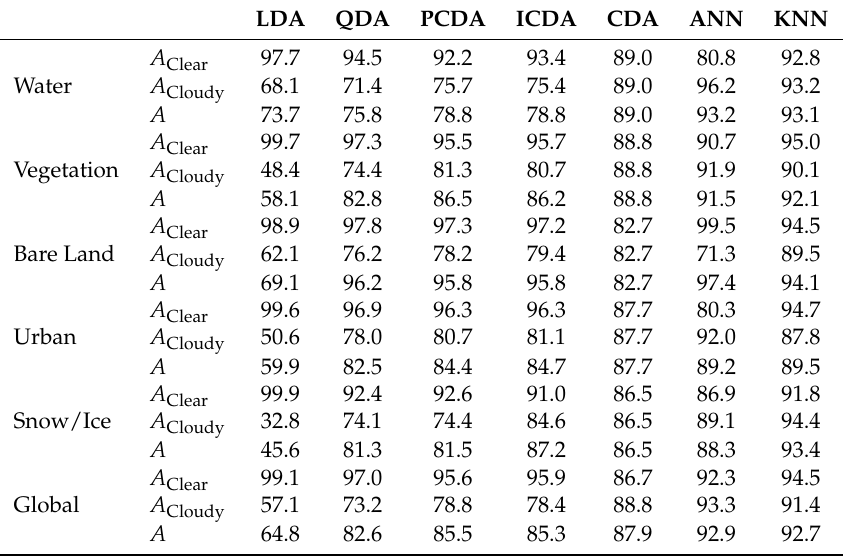
Table 7. Accuracy indicators A , A Clear and A Cloudy of classification methods of Section 3 when validation is made on the full dataset and classifications are separate for each surface type. Percentage values are reported for the entire dataset (row Global) and for the different surface types.